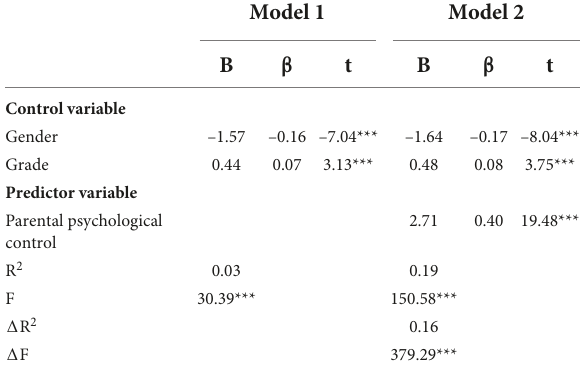
TABLE 2 Multiple linear regression results for testing parental psychological control (PPC) in predicting suicide ideation (SI) ( n = 1971).